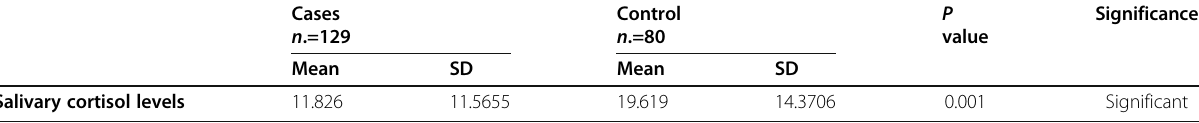
Table 1 Comparison of levels of salivary cortisol between children with ADHD and healthy controls